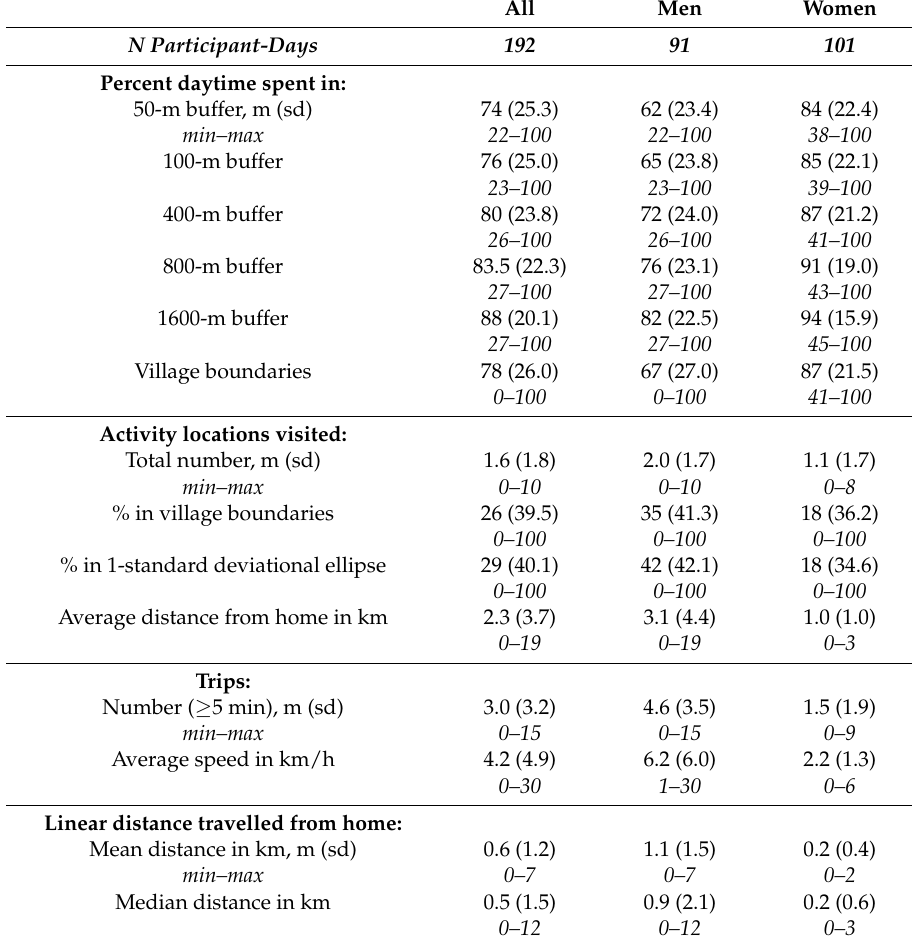
Table 3. Time spent in different locations and travelled distance from